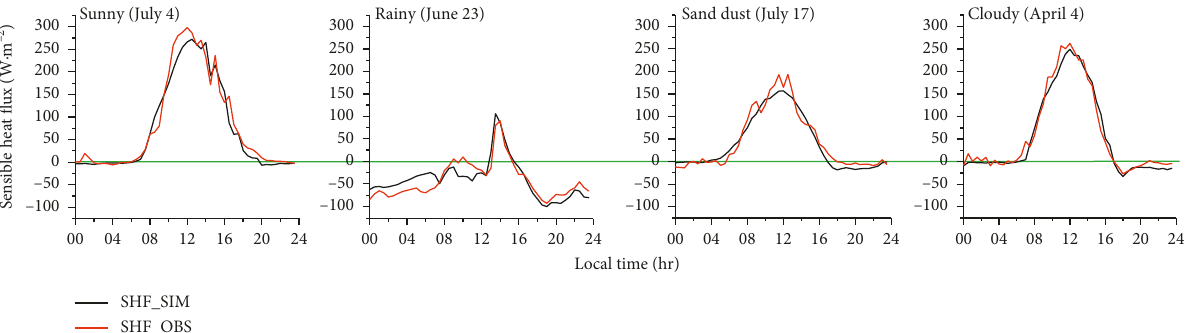
Figure 6: Contrast curve between the simulated (black) and observed (red) sensible heat flux ( H ) during the four weather conditions at the Tazhong station in 2014.